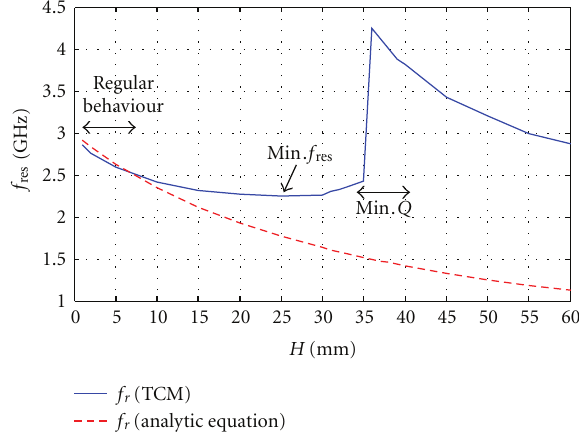
Figure 4: R50 × 30 resonant frequency of the dominant TM 01 mode. The dashed red curve is a quasianalytical equation from